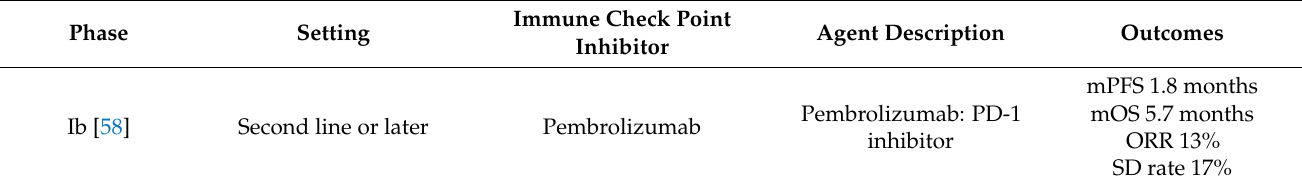
Table 3. Reported outcomes of single-agent immune checkpoint inhibitors in advanced biliary tract cancer (BTC)